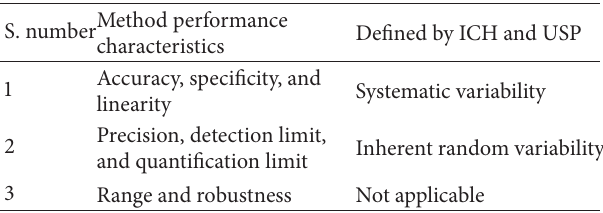
Table 4: Type of method performance characteristics as per USP and ICH Q2